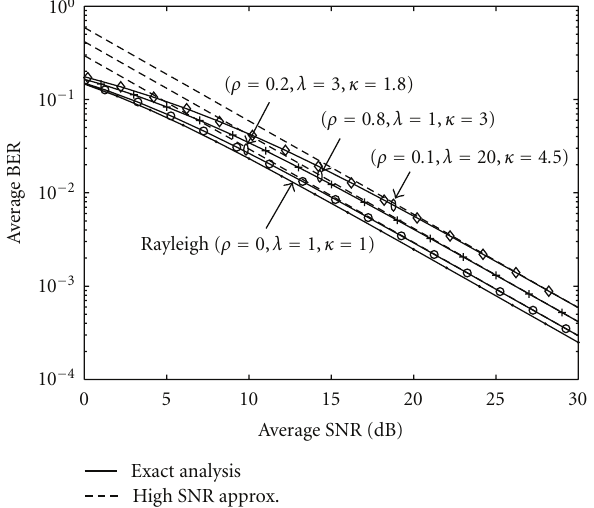
Figure 2: Exact and asymptotic BER for coherent BPSK with correlated bivariate Student-t quadratures for σ c = 1 and for several values of ( ρ , λ , κ